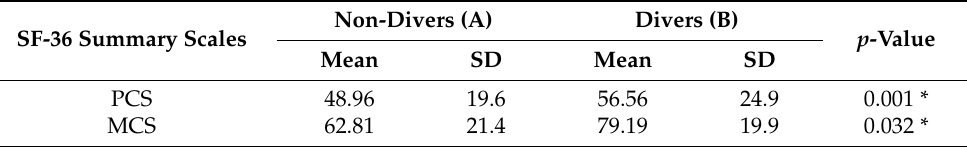
Table 4. Health status assessment of diving and non-diving people with